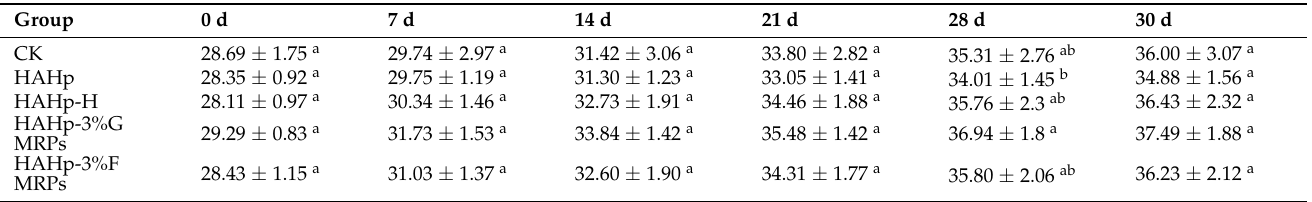
Table 1. Changes in body weight after oral gavage with HAHp, HAHp-H, HAHp-3%G MRPs,